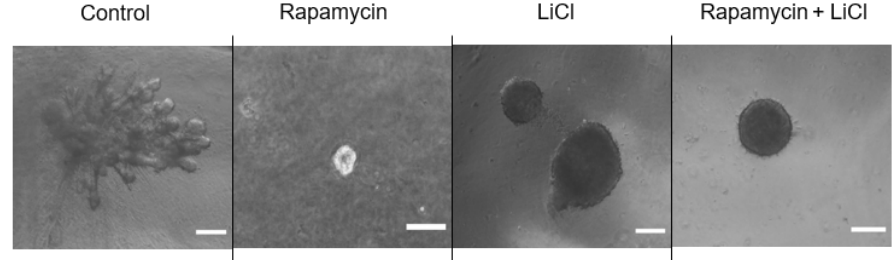
Figure 4. Grown salispheres in collagen:matrigel supported the branching of untreated salispheres (control) within a few days of culture. Collagen:matrigel neither assisted the recovery nor branching of salispheres in the presence of rapamycin alone. LiCl preserved the spherical structure of salispheres and assisted in the survival of salispheres and the maintenance of the spherical cluster in the presence of rapamycin. The scale bar represents 200 µ